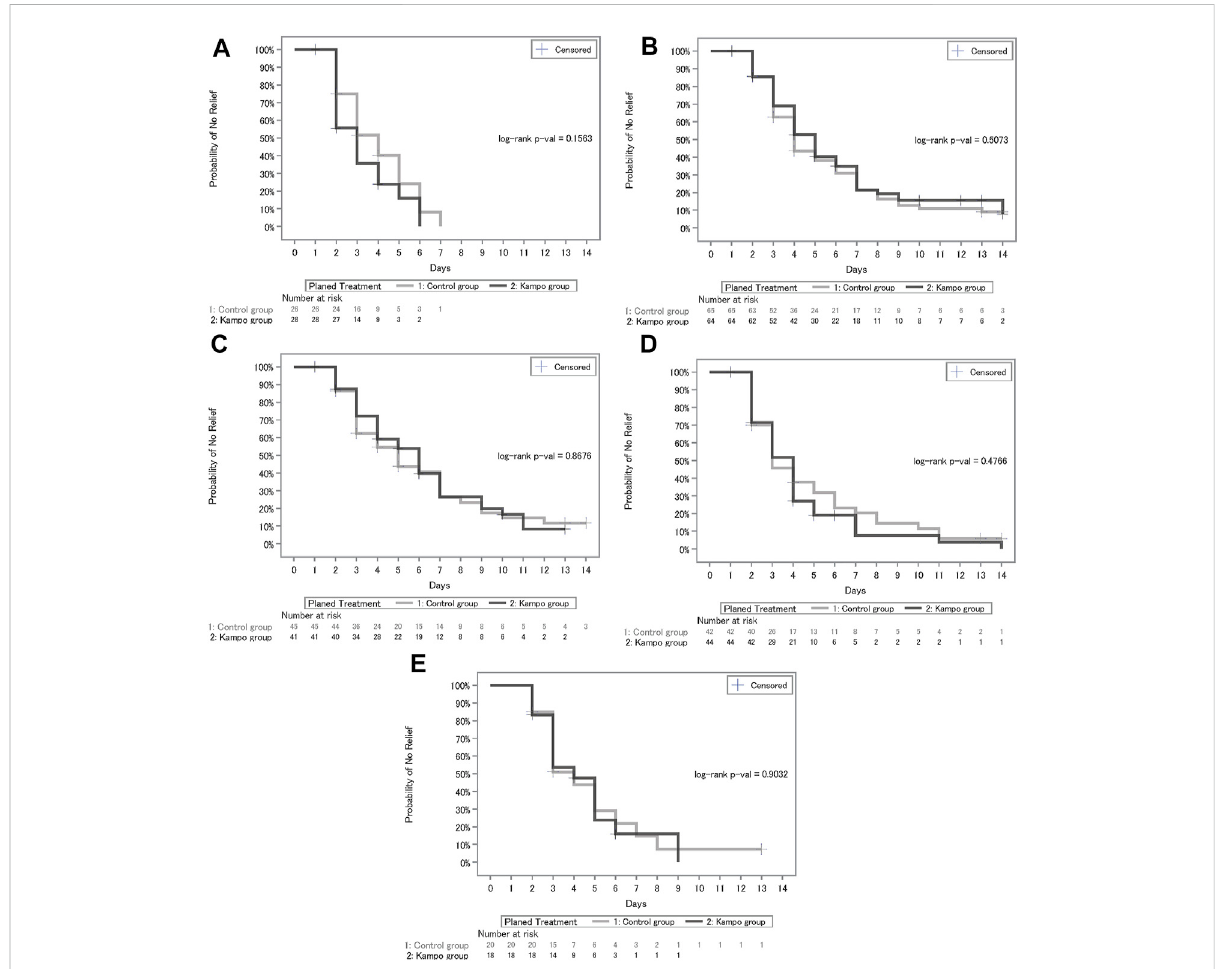
FIGURE 4 (A) Kaplan – Meier curves of days until recovery of fever. (B) Kaplan – Meier curves of days until recovery of cough. (C) Kaplan – Meier curves of days until recovery of sputum. (D) Kaplan – Meier curves of days until recovery of fatigue. (E) Kaplan – Meier curves of days until recovery of shortness of